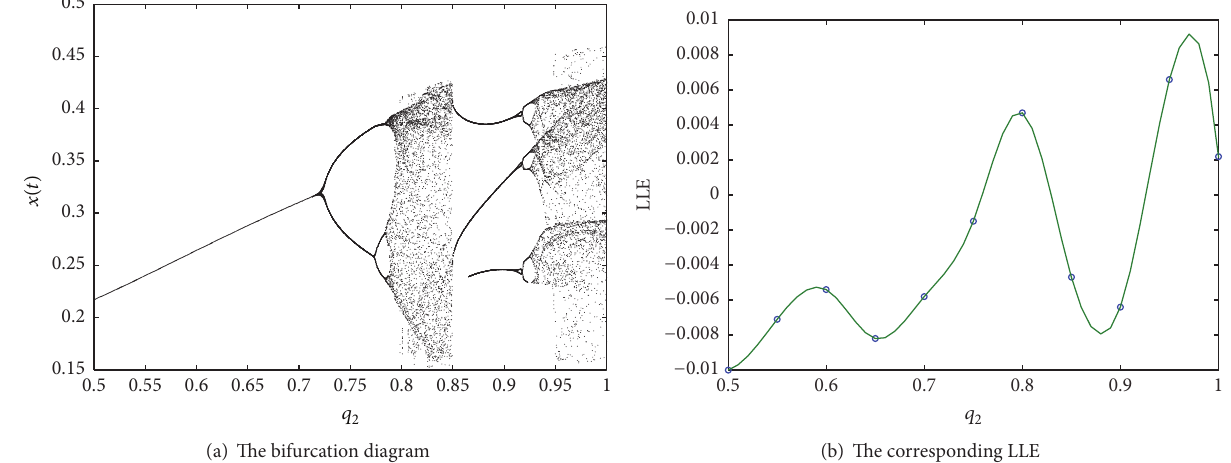
Figure 4: The bifurcation and the corresponding LLE diagrams of system (2) with the order 𝑞 2 ∈ [0.5, 1] .